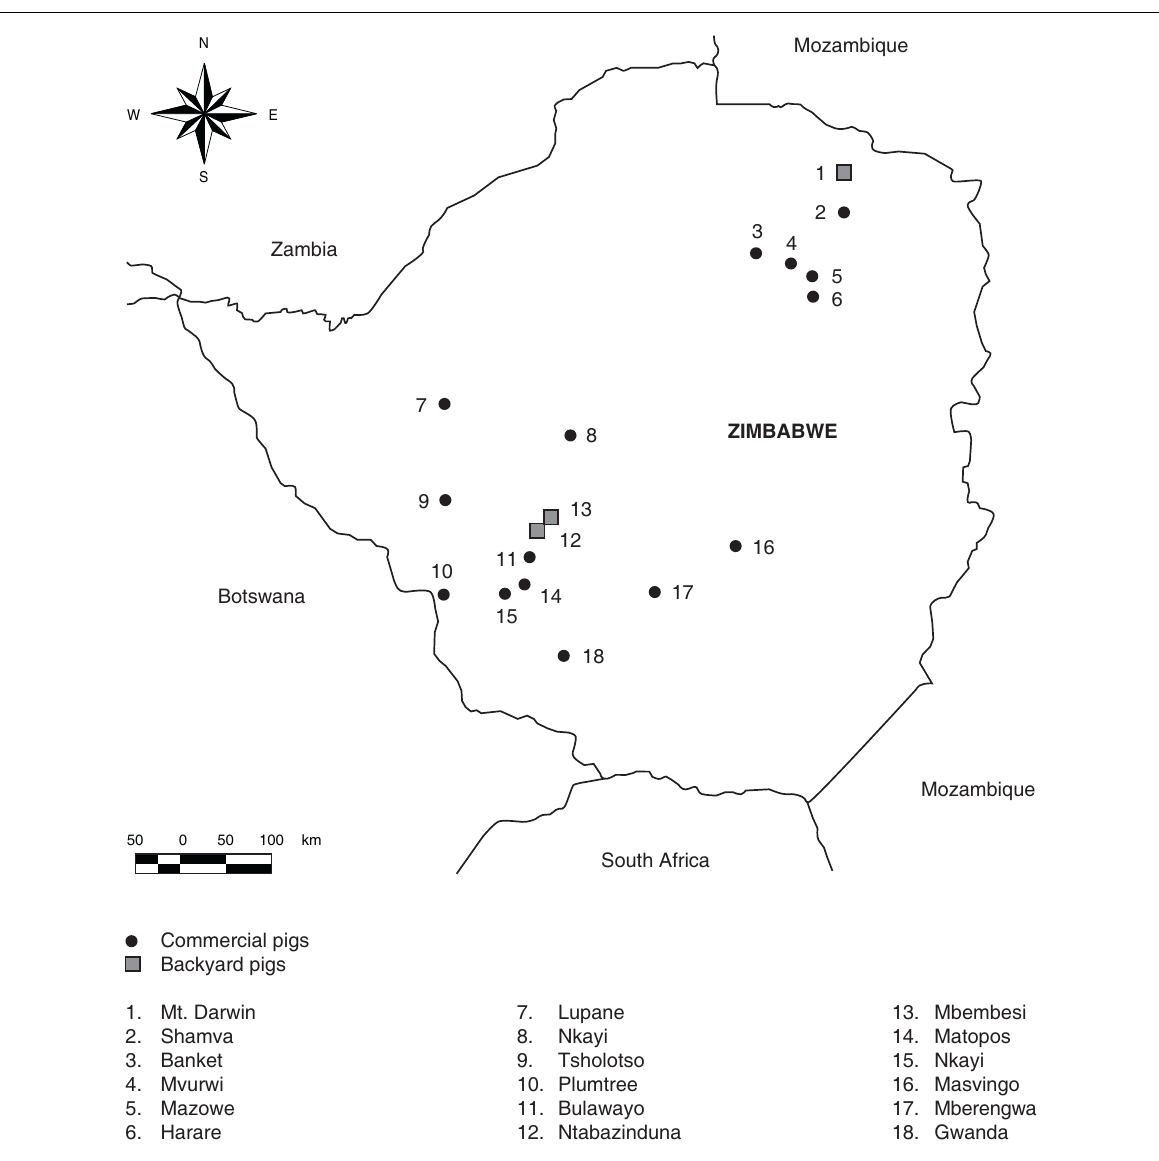
FIG. 1 Map of Zimbabwe showing the centres of the districts from where the pigs sampled